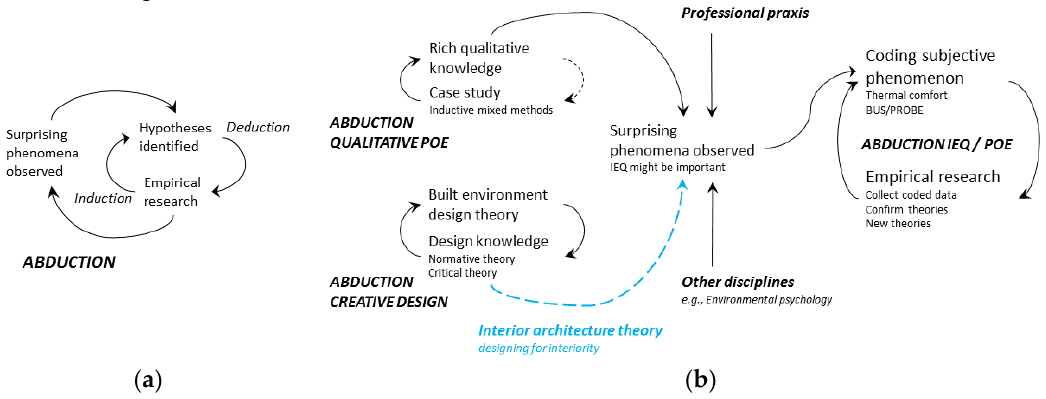
Figure 1. ( a ) Abduction; and ( b ) interconnected/sequential abduction in IEQ/POE.